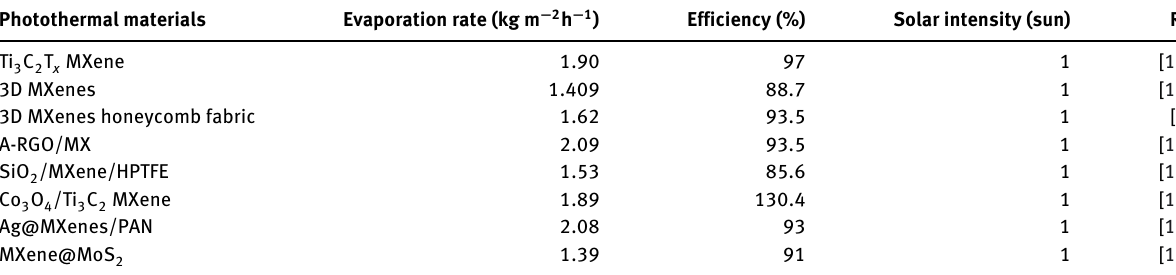
Table 3: The energy conversion performances of different MXenes. Photothermal